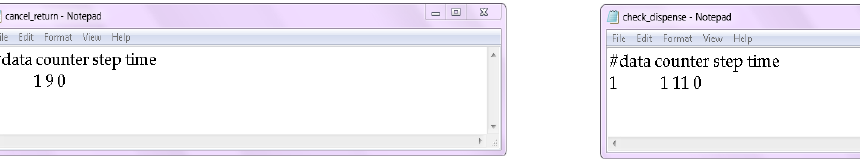
Fig. 17. Monitor output of the first characteristic Fig. 18. Monitor output of the second